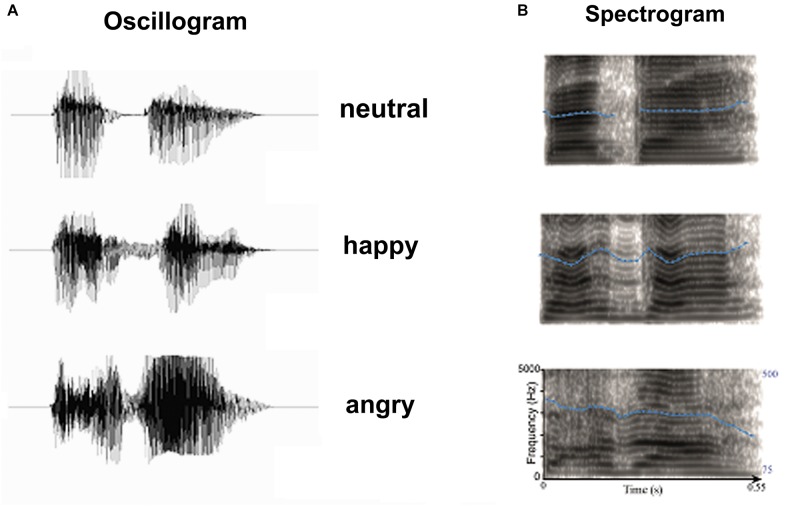
Acoustic properties of stimulus materials: (A) Oscillogram and (B) Spectrogram of auditory stimulus. Blue dot lines in the spectrum denote the flow of fundamental frequency at each time point, which represents the pitch flow of emotional syllables.